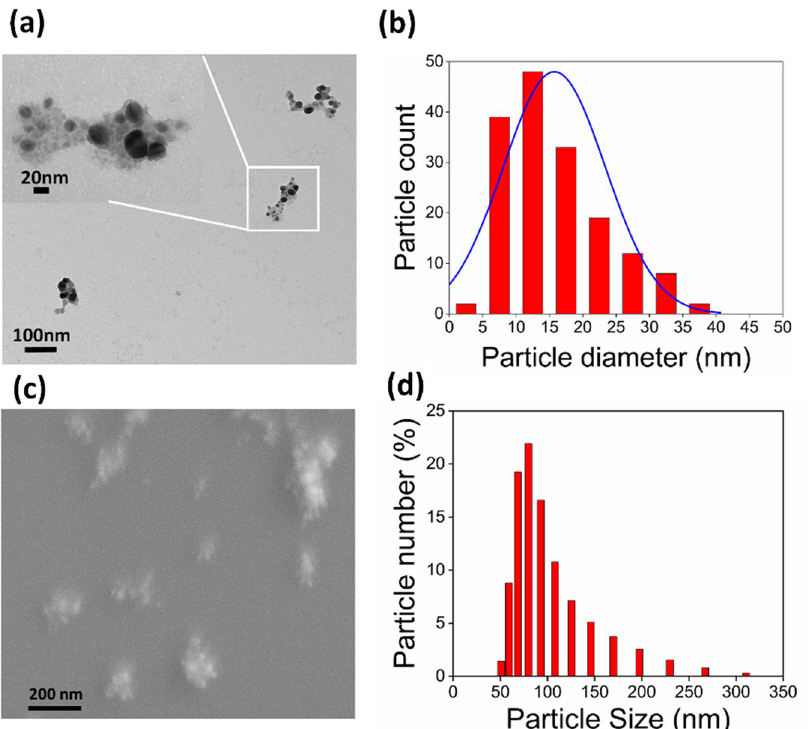
Figure 2. Size and morphology analysis. ( a ) TEM study depicts the spherical nature of the SL-SpNPs, inset shows the cluster of NPs stabilized by SPE. ( b ) The bar plot based on TEM analysis represents the size range of SL-SpNPs as 4.5–39.7 nm with an average of 15.38 nm. ( c ) Similarly, the FE-SEM analysis shows spherical nature of the NPs with small clusters. ( d ) However, the DLS analysis showed variable size percentage with an average of 79 nm of synthesized SL-SpNPs.